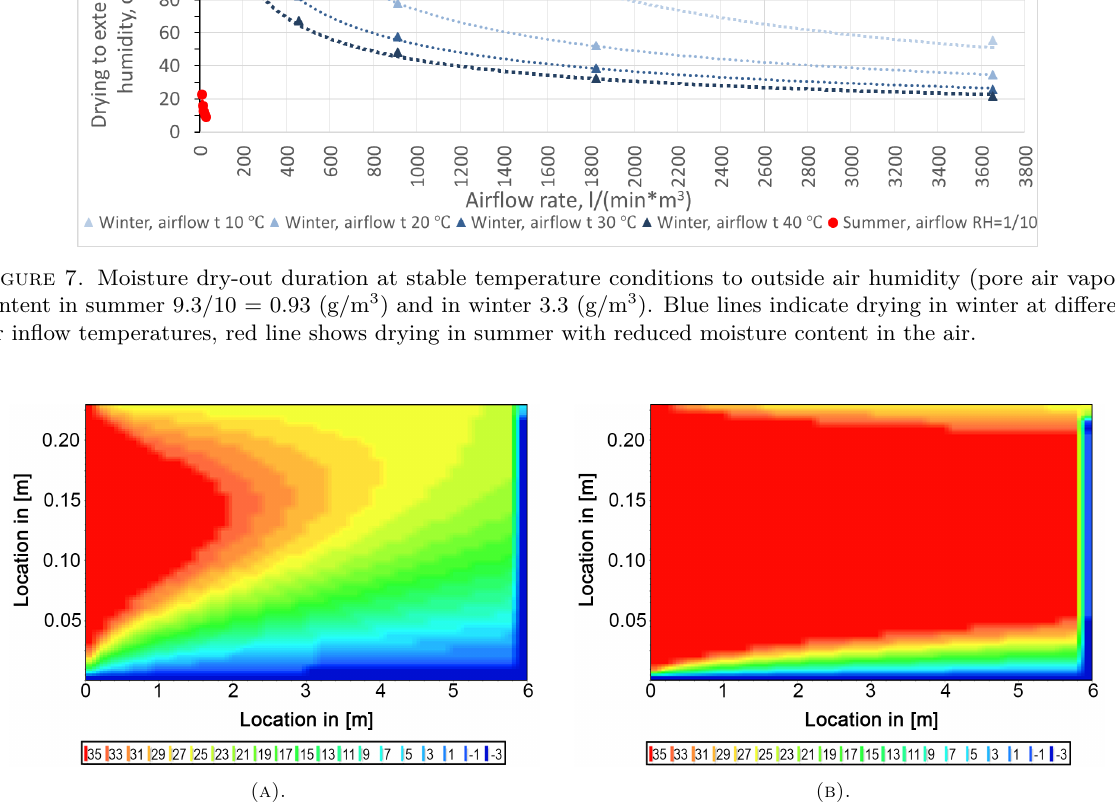
Figure 8. Temperature distribution on top view of the wall (vertical length 0.23 m and horizontal length 6 m), winter period, air inflow temperature +40 °C (A) airflow rate 228 l/(min · m 3 ) (B) airflow rate 3 650 l/(min · m 3 ). Red area shows temperature over +35 °C and navy blue is for areas under -3 °C.